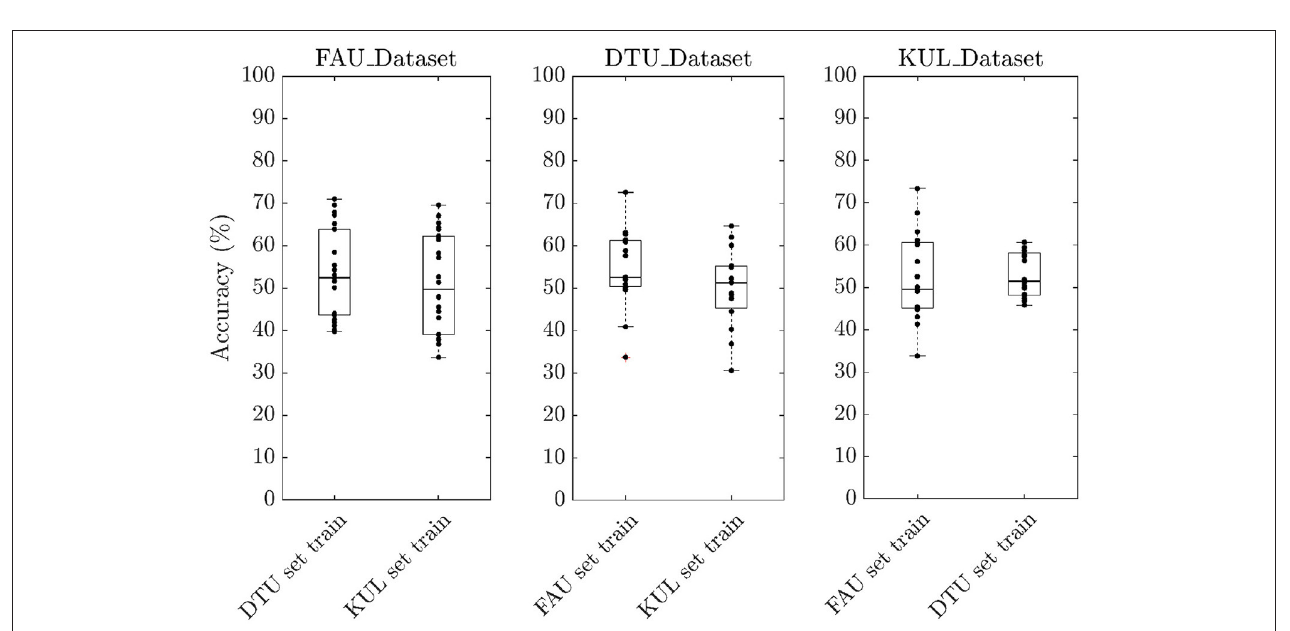
FIGURE 3 | Boxplot showing the decoding accuracies obtained for cross-set training scenario. The accuracies obtained were all at chance